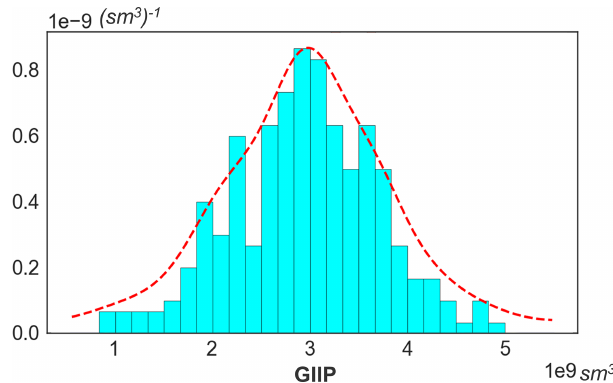
Figure 7. Uncertainty quantification of GIIP based on prior uncer- tainty and four boreholes.